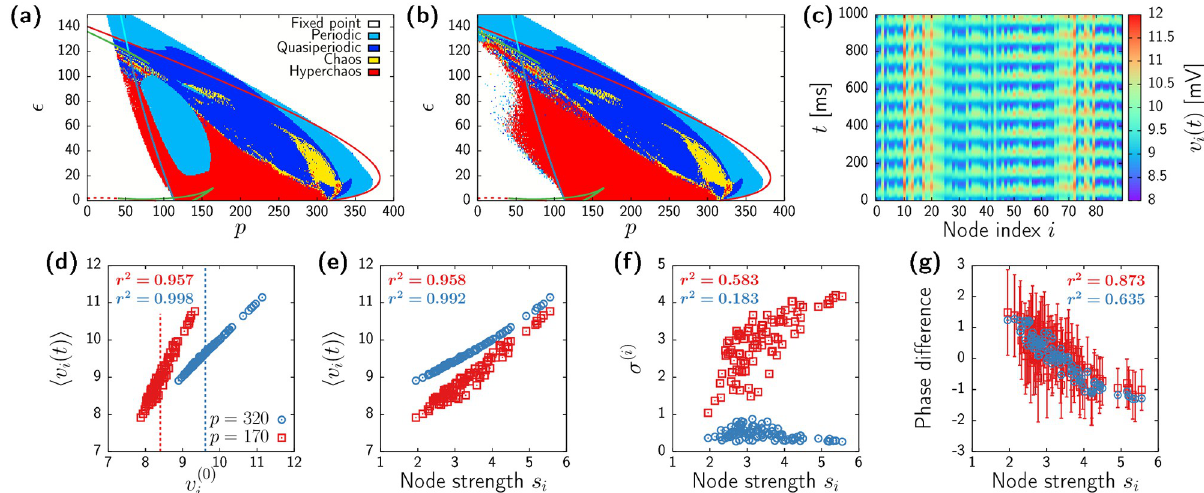
Fig 6. Dynamics of the Jansen model with unnormalized connectivity. (a) Numerical bifurcation diagram as obtained from the Lyapunov analysis of numerical simulations. Initial conditions set close to homogeneous. Continuous lines identical to those of Fig 1(f). (b) Same than (a), but initial conditions set at random. (c) Time evolution of each network node for p = 320 and � = 50 starting with random initial conditions. (d,e,f,g) Relation between different measures obtained from numerical simulations for � = 50 and p = 320 (red circles) and p = 170 (blue squares). The corresponding squared Pearson’s correlation coefficients r 2 are displayed in each plot. (d) Correlation between oscillation focus h v ( i ) i and the underlying unstable fixed . Dashed vertical lines correspond to the homogeneous fixed points of the normalized system ~ W . (e) Correlation between oscillation focus point v ð i Þ 0 h v ( i ) i and node strength s . (f) Correlation between oscillation amplitude σ ( i ) and node strength s i and node strength s i . Error bars correspond to temporal standard